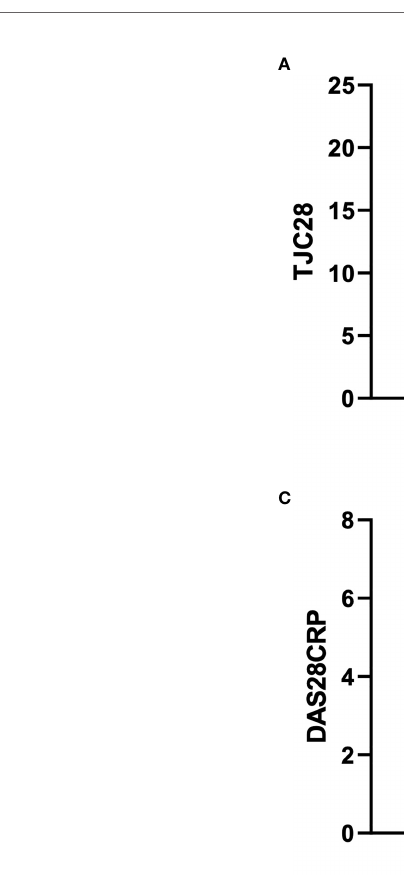
FIGURE 1 | Evolution of disease activity in n = 14 patients between W0 and W16 of treatment with abatacept. (A – D) Effect of abatacept on TJC28 (A) , SJC28 (B) , DAS28CRP (C), and US gray-scale score (D) . p-values: Wilcoxon matched-pairs ranked test. Overlapping points are offset for clarity of representation in (D)